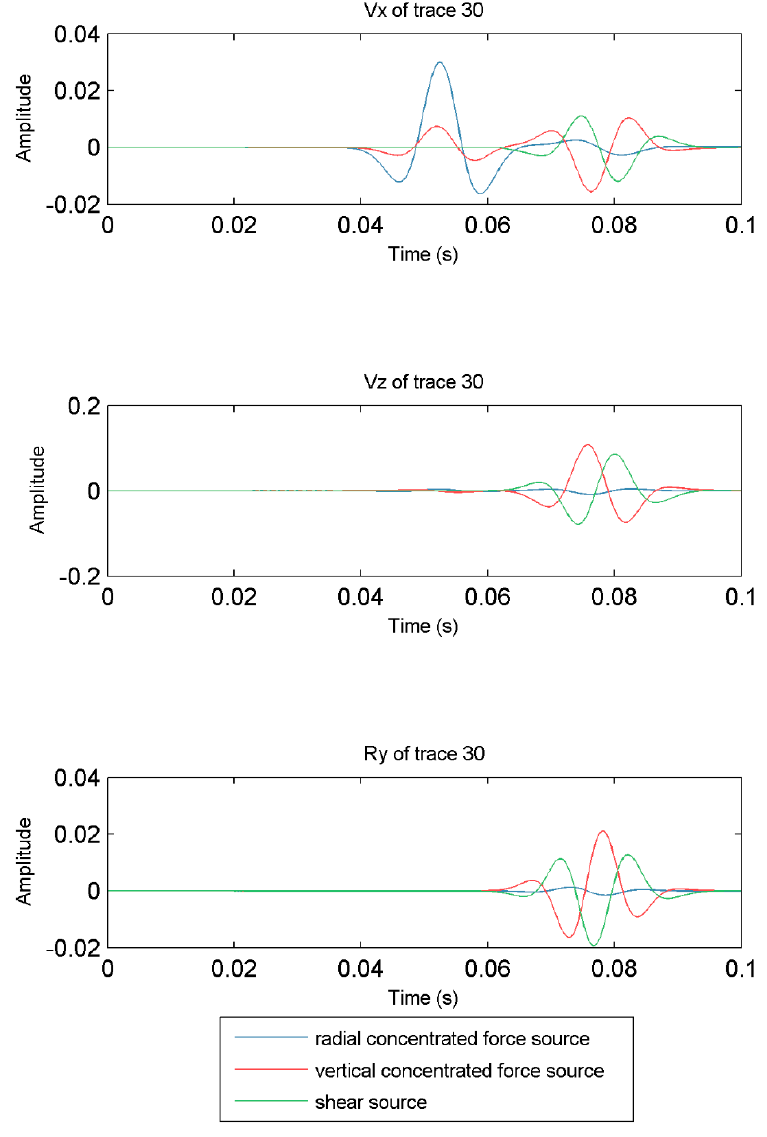
Figure 3. Seismograms of the 30th trace.